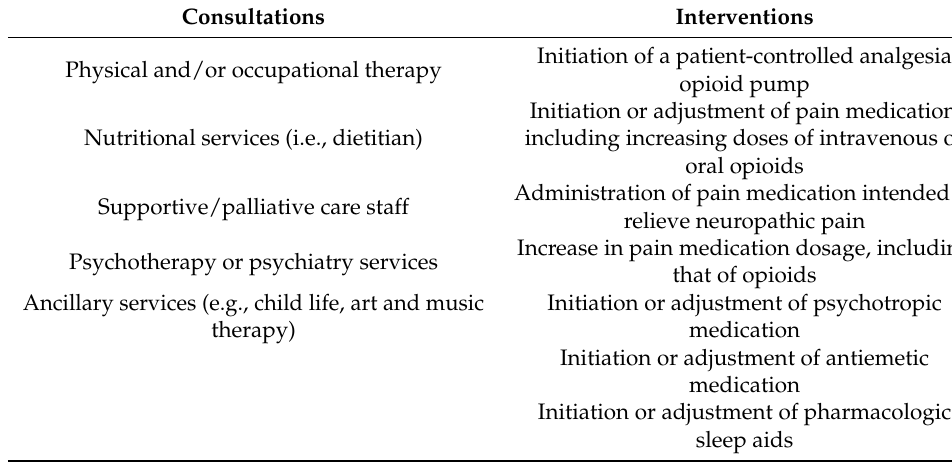
Table 2. Types of interventions and consultations that occurred within one day of MDASI-Adolescent (MDAS-Adol)